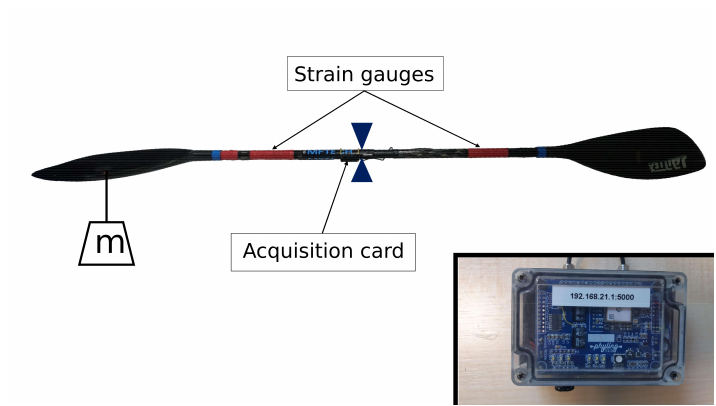
Figure 3. Calibration of the instrumented paddle used for the experiments. The mass “m” symbolizes the mass of calibration. On the right bottom corner, we show the waterproof box MaxiPhyling placed on the boat.